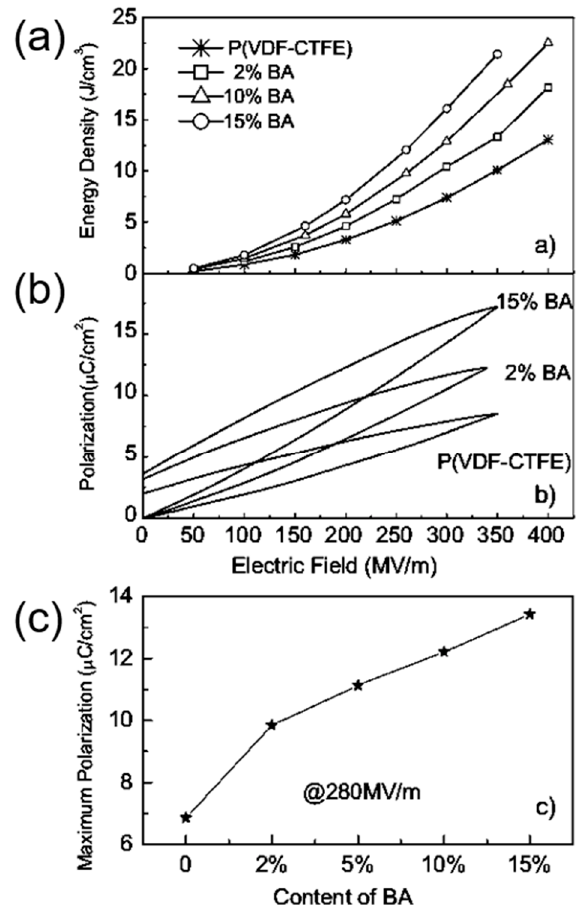
Figure 1. ( a ) Discharge energy density in (PVDF-CTFE) with different contents of cross-link agents. ( b ) Example of enhanced polarization in the cross-linked polymers shown by P–E loops at around 350 MV/m. ( c ). The maximum polarization of the copolymers at 280 MV/m. Reprinted with permission from [8]. Copyright 2011 WILEY-VCH Verlag GmbH & Co.